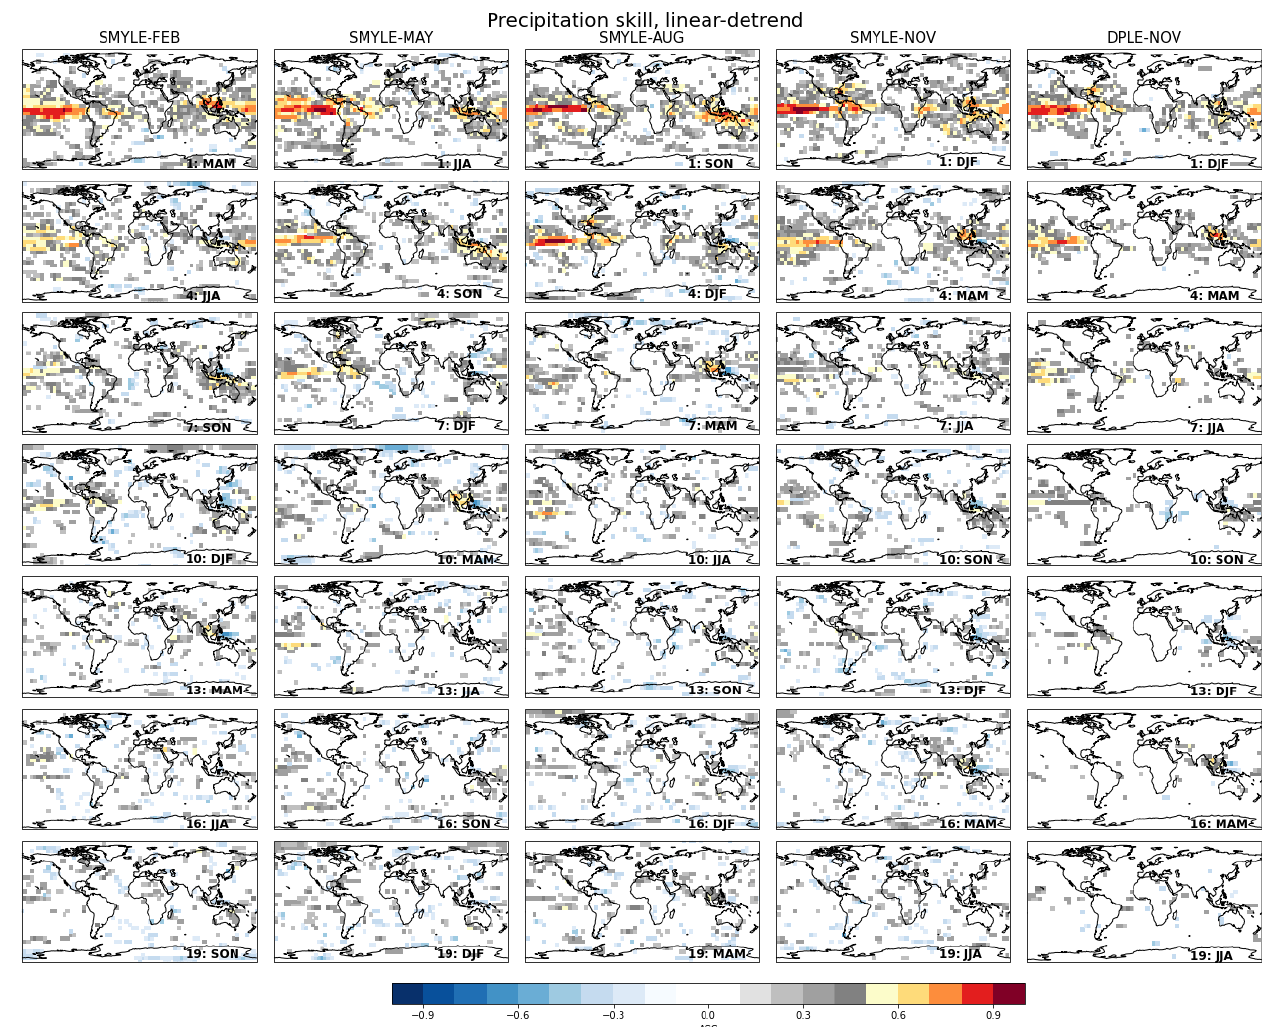
Figure 2. Anomaly correlation coefficient (ACC) for precipitation after removing a linear trend. Columns correspond to different 20-member hindcast sets from SMYLE, with the far-right column showing 20-member DPLE results. Rows correspond to forecast season as indicated by labels that give forecast lead time and target season. Correlations are plotted only where significant ( p < 0.1). Verification is against the GPCP v2.3 (Adler et al., 2018) dataset that spans 1979–2021. Figure B2 shows corresponding maps for non-detrended data, and Fig. B4 shows where SMYLE-NOV differs significantly from